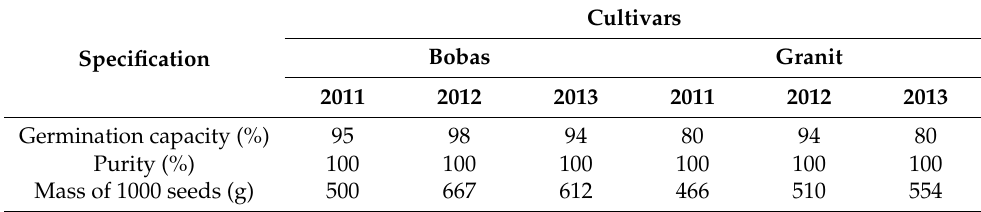
Table 2. Characterization of seeds